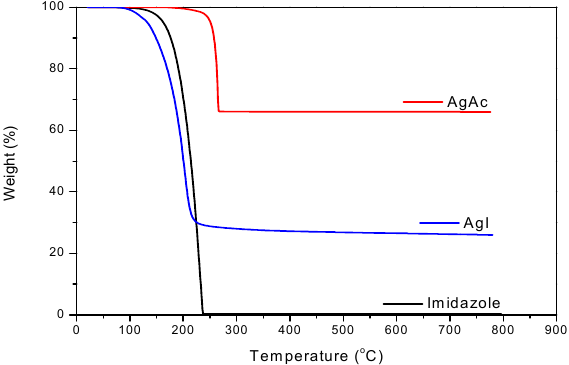
Figure 3. Thermogravimetric analysis thermograms of imidazole, silver–imidazole complex (AgI), and silver acetate (AgAc). Table 1. Energy-dispersive X-ray spectroscopy data for epoxy/silver nanocomposites cured with